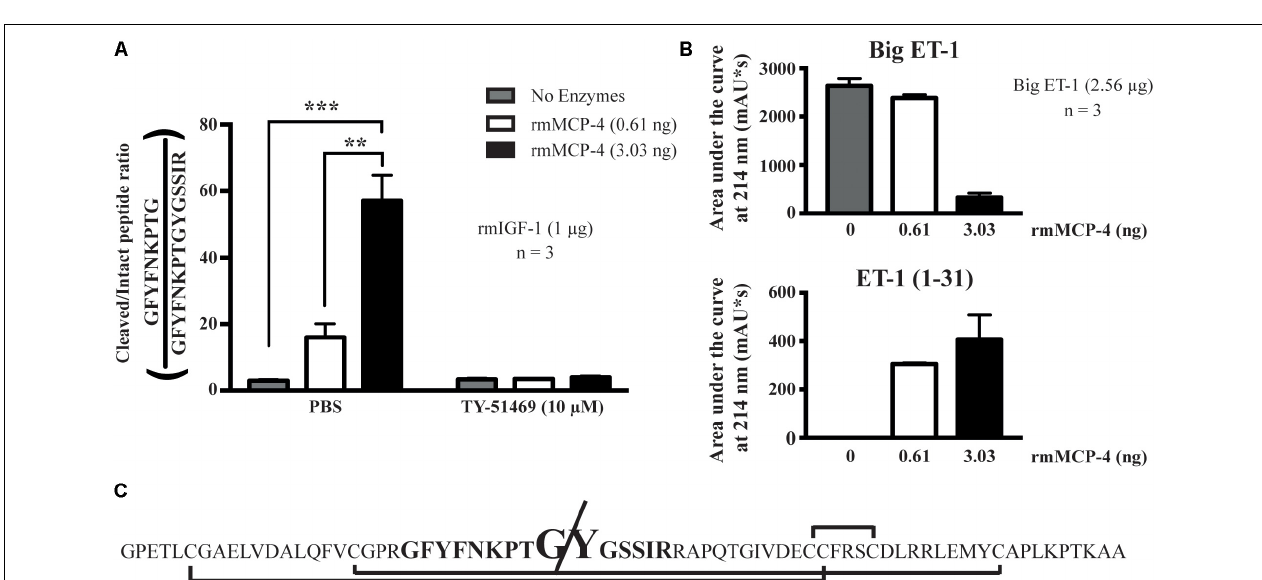
FIGURE 6 | Tissue levels of IR-ET-1 1 day after surgery. The levels of immunoreactive ET-1 were measured in the lungs and left heart ventricle. #: PMI vs. SHAM, ∗ : WT vs. mMCP-4 KO, n = 5–7, one-way ANOVA with multiple comparisons Holms-Šidak post-test).